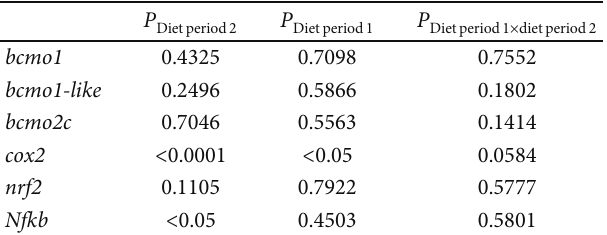
Table 5: P values for e ff ects of diet in periods 1 or 2 on the expression on the three carotenoid oxygenase genes and cox 2, nrf 2 and